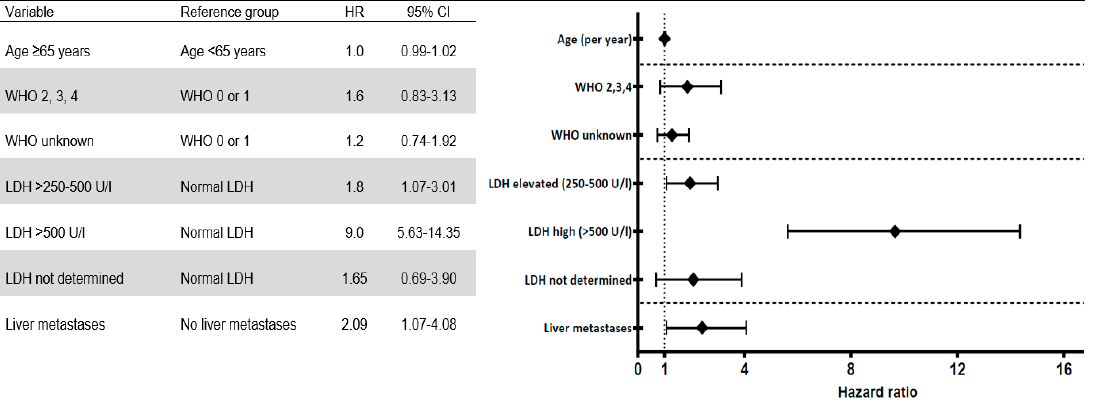
Figure 6. Kaplan-Meier Estimates for all 175 metastatic UM patients and per treatment strategy administered when diagnosed with metastatic disease. ( A ) Kaplan-Meier (KM) estimate for all metastatic UM patients, ( B ) KM estimate for patients treated with systemic therapy, ( C ) KM estimate for patients with local treatment, ( D ) KM estimate for patients receiving no tumor directed treatment (best supportive care.